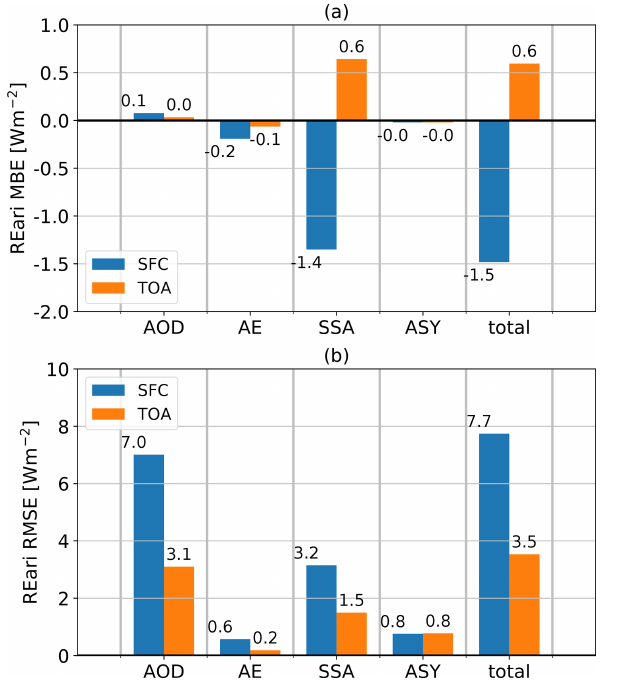
Figure 6. Mean bias (a) and RMSE (b) estimates of simulated REari at the surface (blue) and top of the atmosphere (orange). The estimates are computed from REari kernels weighted by MBE and RMSE of the CAMS RA aerosol optical properties compared to the AERONET aerosol products.